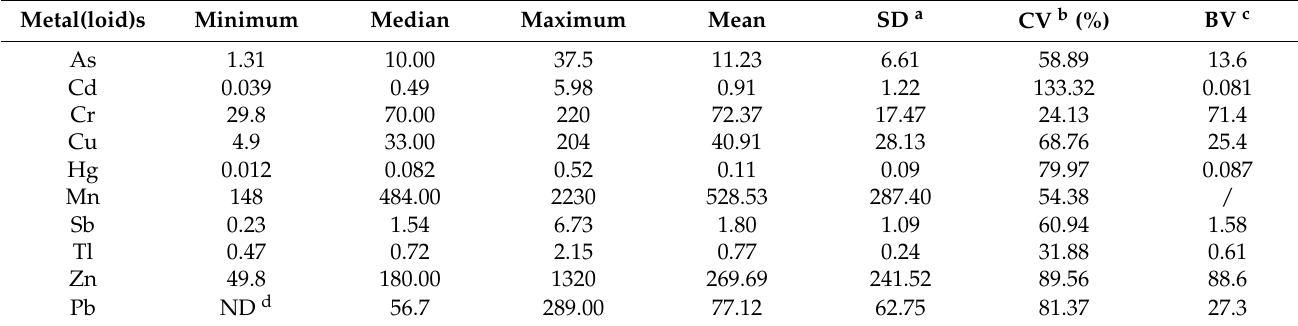
Table 1. Characteristics of the content of toxic metal(loid)s in the soil of the abandoned mine.